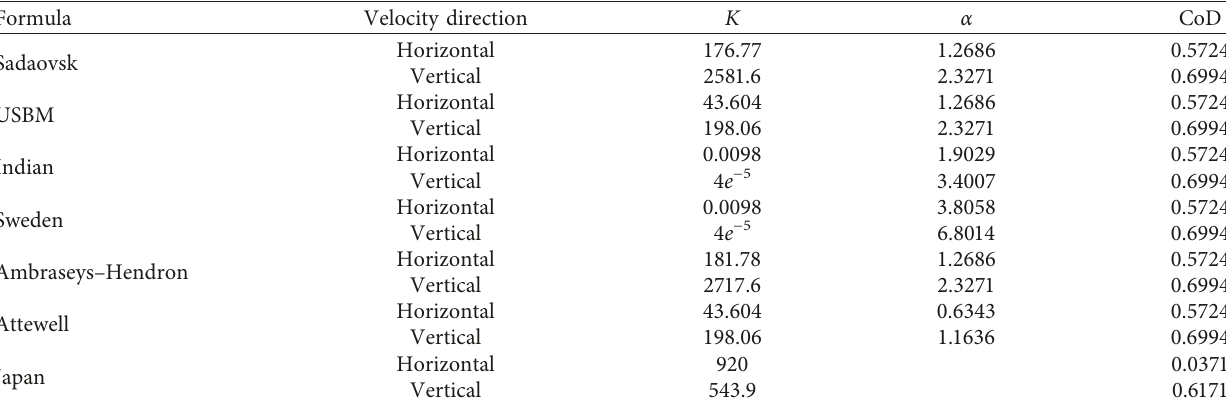
Table 4: Calculated values of K and α .